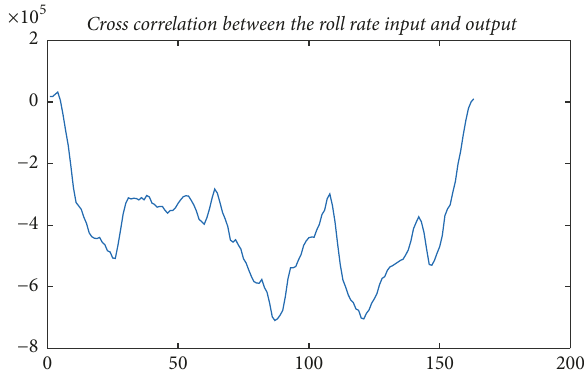
Figure 20: Cross correlation between the wing warping input and roll rate output of the FMW mini-UAV with